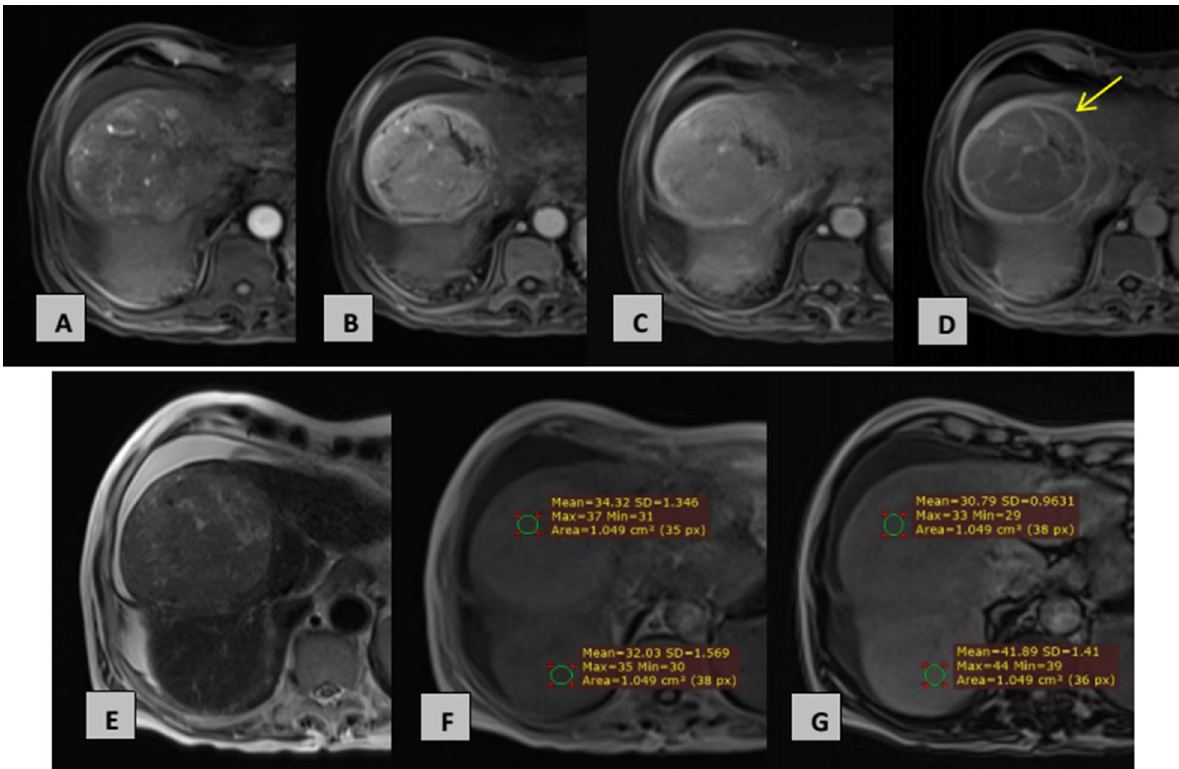
Fig. 2 A 70-year-old male patient with moderate cirrhosis and a single HCC lesion in segments IV and VIII of his liver. A Early arterial phase, B late arterial phase, C portal phase, D delayed phase E T2WI, F in-phase gradient echo, G opposed phase gradient echo. The lesion elicits moderate high T2 signals and shows early non-rim APHE and non-peripheral contrast washout. Mild amount of ascites is present. Hepatic fat fraction: 0% (no steatosis). Major HCC features: non-rim APHE (early), non-peripheral “washout,” size in this patient (non-steatotic